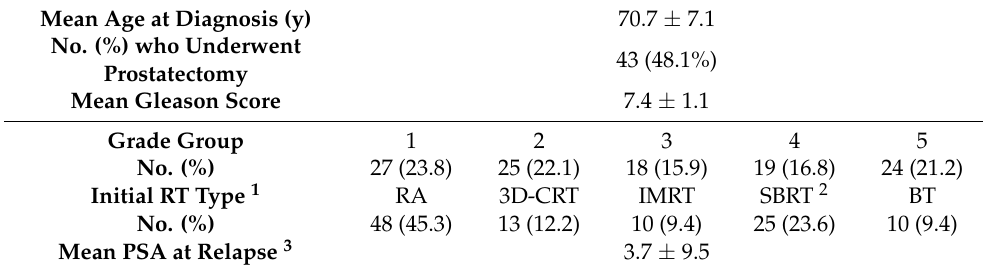
Table 1. Disease characteristics of the cohort prior to salvage radiotherapy. Mean Age at Diagnosis